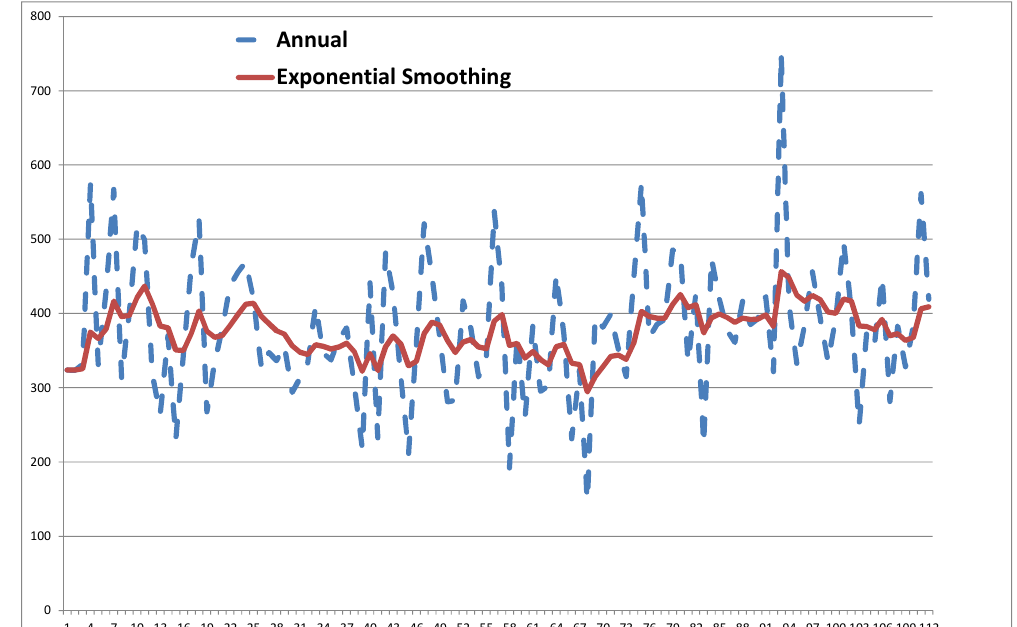
Figure 5. Annual rainfall totals for Callington from 1900 to 2011.